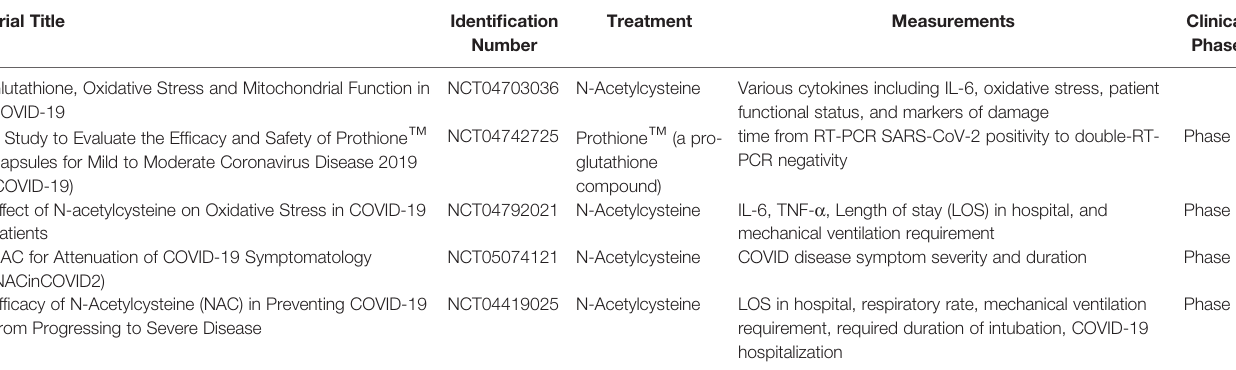
TABLE 3 | Current glutathione-relevant clinical trials in COVID-19 patients and their corresponding clinicaltrials.gov identi fi cation numbers, treatments, measured parameters, and clinical